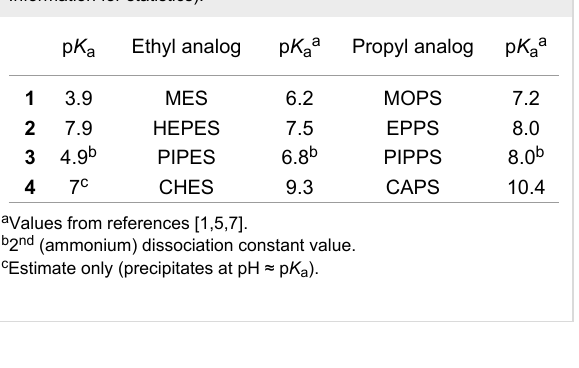
Table 1: p K a comparison of aminoalkylsulfonates. Acronyms refer to compounds in the Good’s buffer series that are commercially available. Some of the less common ones are CHES [2-(cyclohexylamino)- ethanesulfonic acid], EPPS [4-(2-hydroxyethyl)-1-piperazinepropane- sulfonic acid], PIPPS [piperazine- N , N ′ -bis(3-propanesulfonic acid], and CAPS [3-(cyclohexylamino)-1-propanesulfonic acid]. Experimental values reported at or above precision of measurement (see Supporting Information for statistics).